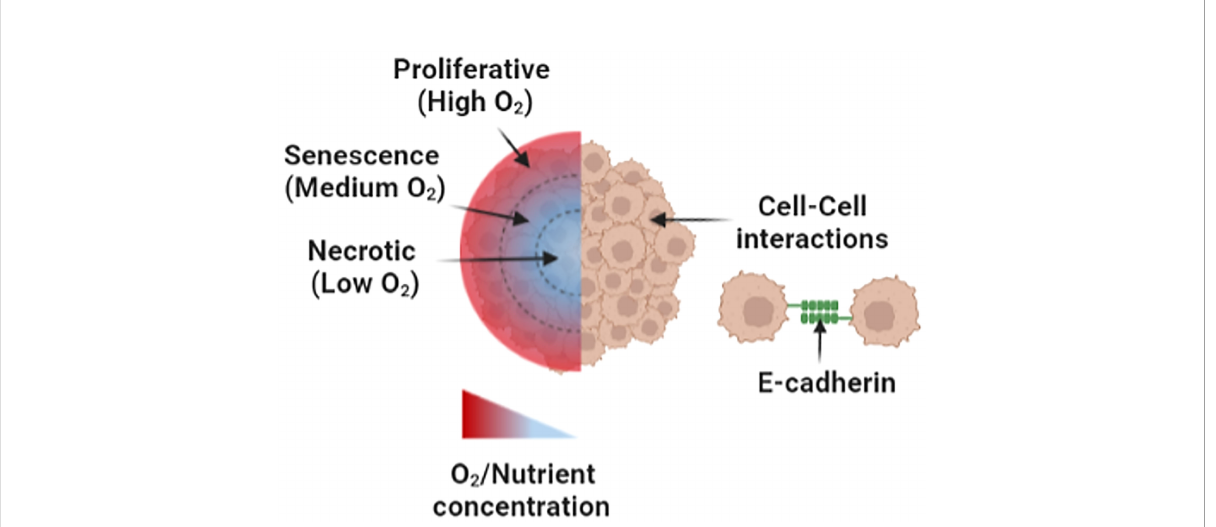
FIGURE 4 An illustration of spheroid culture model. Hypoxic gradients within spheroid cultures comprise an outer high-oxygen/nutrient region, a middle medium-oxygen/nutrient region, and a low-oxygen/nutrient region. In addition, cell – cell interactions take place in the spheroid model via functional cell aggregation and E-cadherin binding. Figure created with